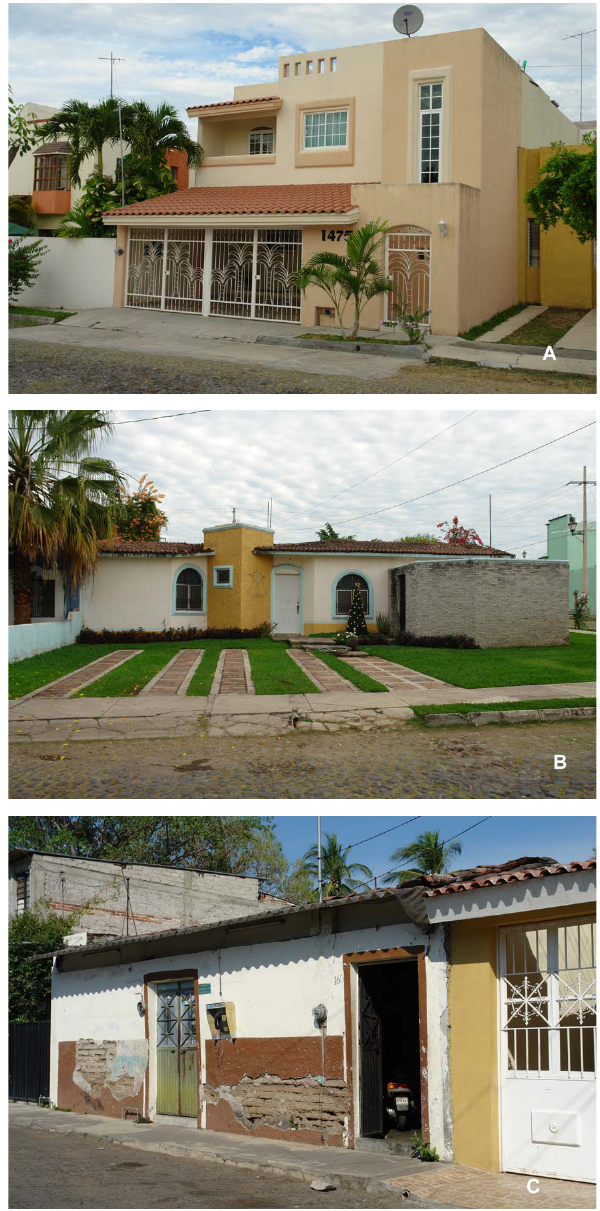
Fig. 2. Examples of three types of buildings: type A (A) , type B (B) , and type C (C) .